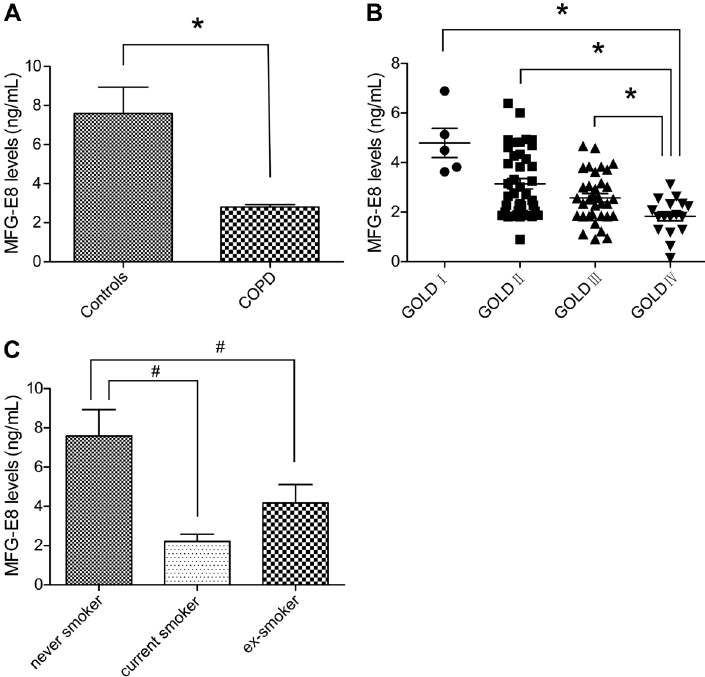
Figure 1. A , Plasma milk fat globule epidermal growth factor 8 (MFG-E8) levels in healthy controls and patients with chronic obstructive pulmonary disease (COPD). B , Plasma MFG-E8 levels in COPD patients differing in the severity of their disease. Global Initiative For Chronic Obstructive Lung Disease (GOLD) criteria: GOLD I (mild); GOLD II (moderate); GOLD III (severe); GOLD IV (very severe). C , Plasma MFG-E8 levels among never, current, and ex-smokers. A : *P o 0.05